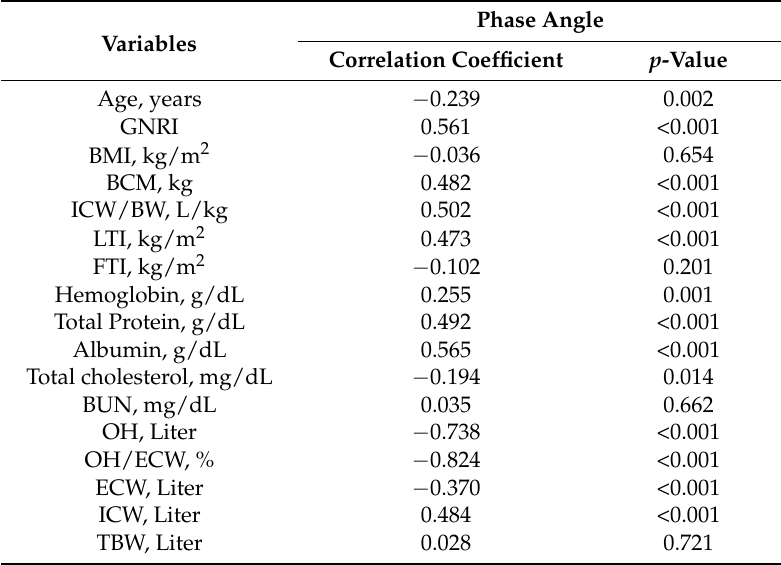
Table 2. Univariate analysis of nutritional markers, serum laboratory tests, and volume markers in association with the phase angle.